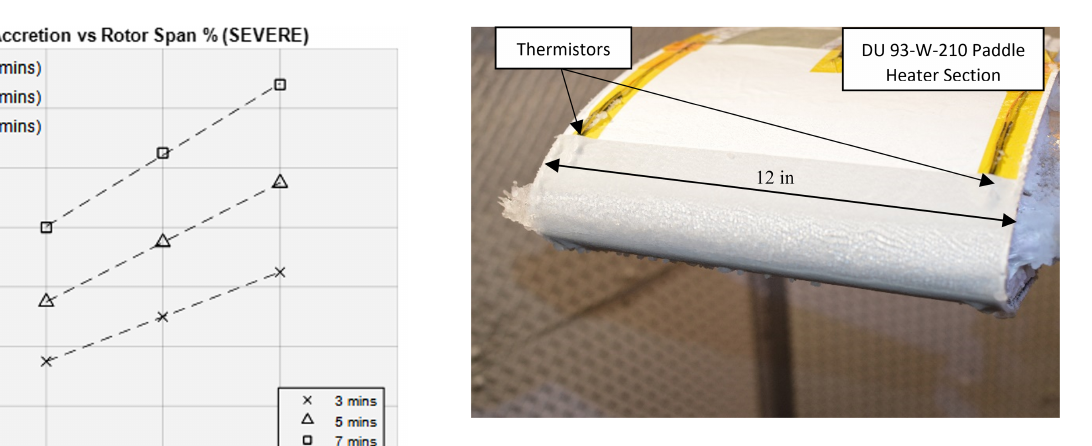
Figure 16. Heater section with 4mm ice accretion before ice re- moval.